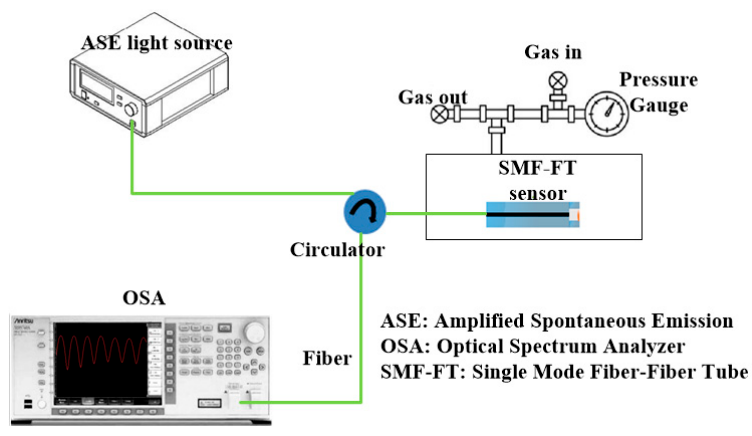
Figure 7. Experimental setup.